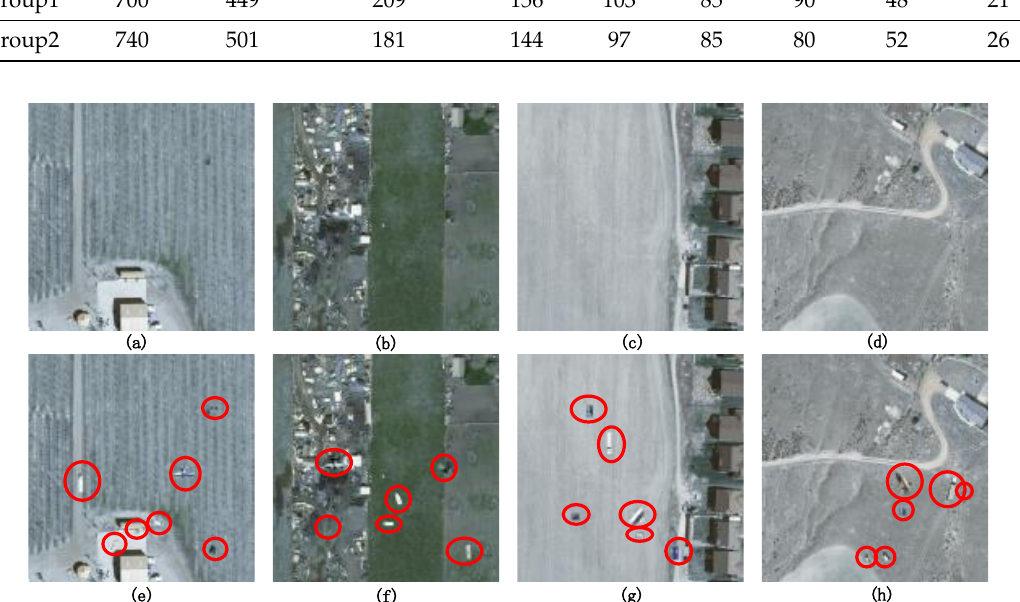
Figure 8. Comparison of images before and after augmentation by the oversampling and stitching method. ( a – d ) are original images from VEDAI dataset, and ( e – h ) are images synthesized by proposed method corresponding to ( a – e